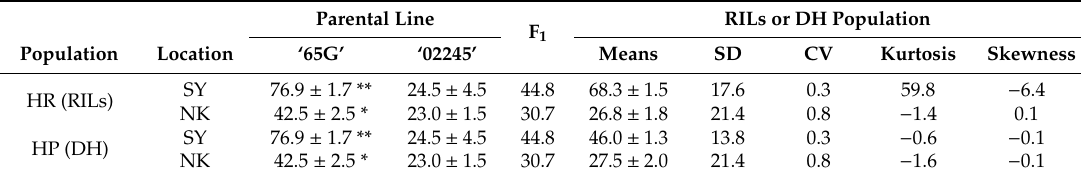
Table 1. Frequency distribution of HII in recombinant inbred lines (RILs) and double haploid (DH) populations.